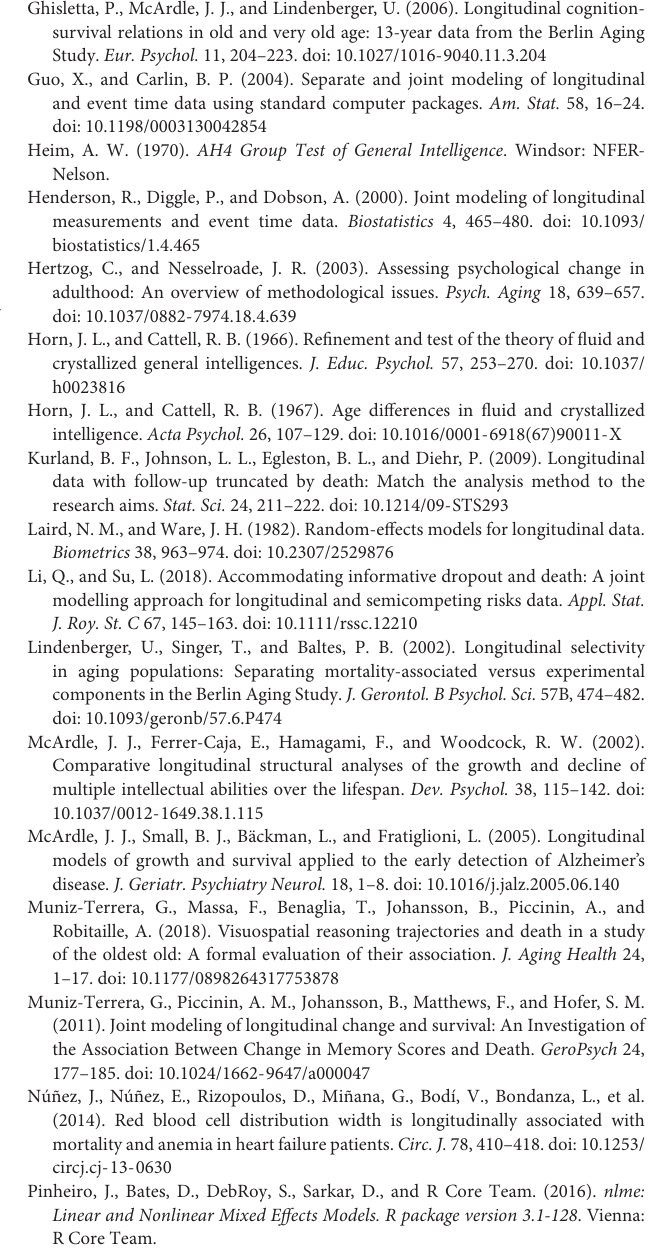
Supplementary Data Sheet 2 | Simulated data to run with JM Bayes example script. Supplementary Data Sheet 3 | Model fit comparisons summary